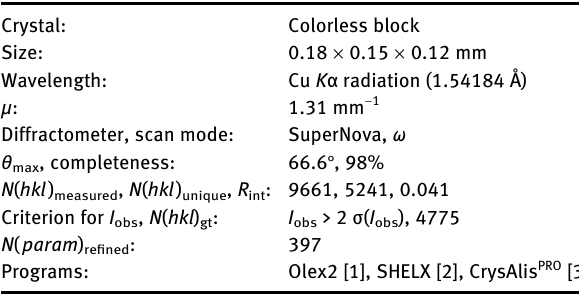
Table  : Data collection and